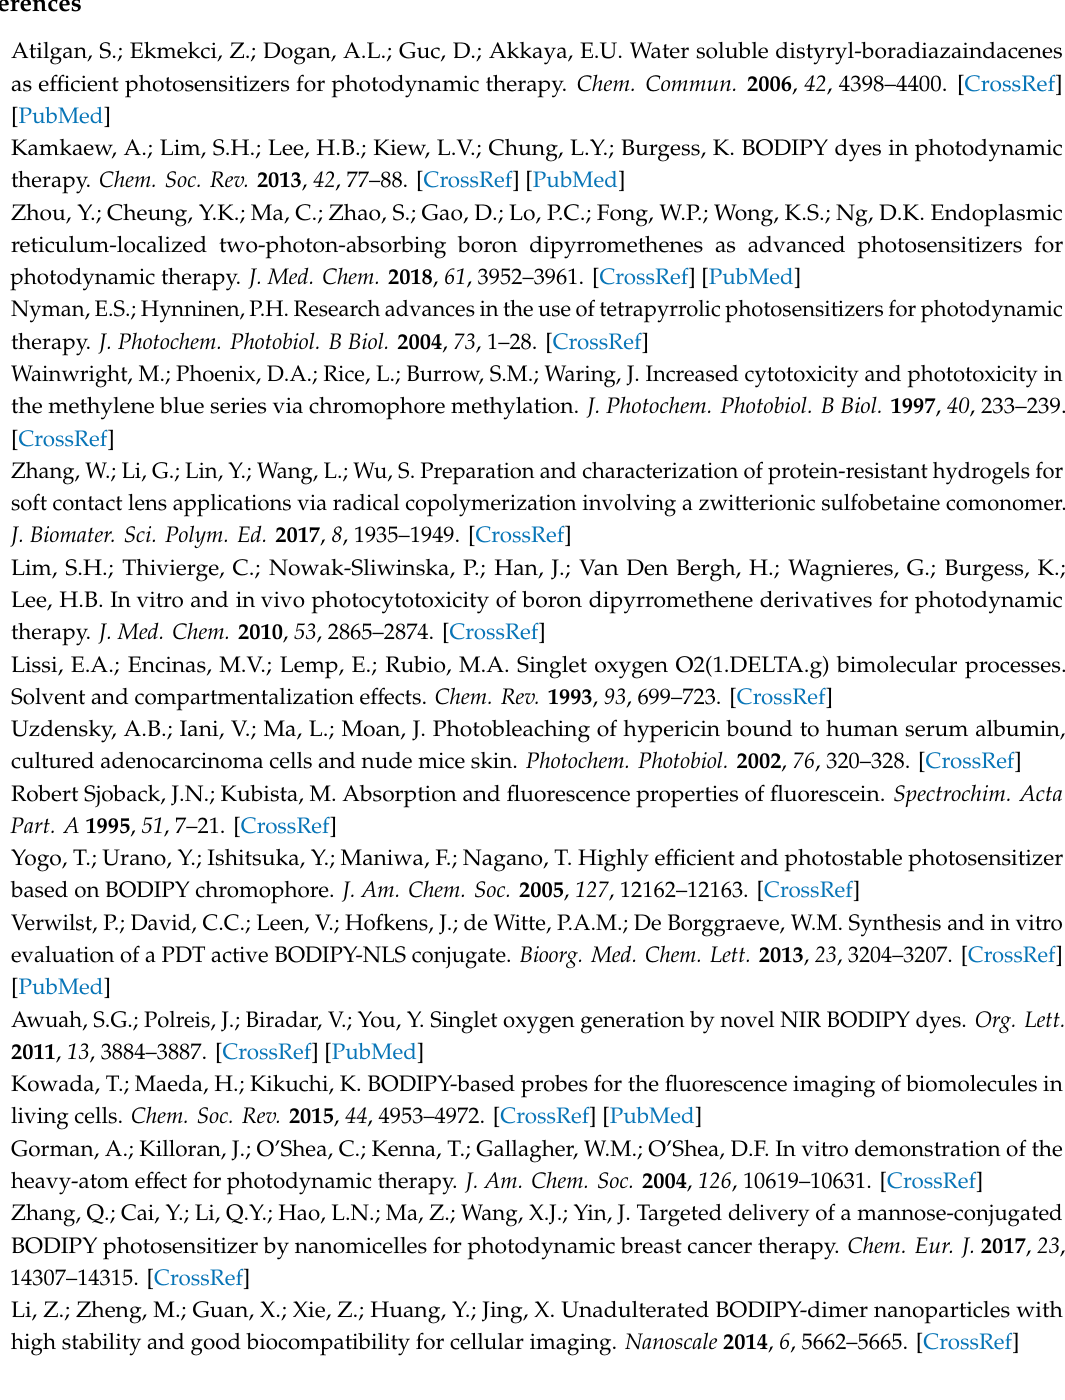
BODIPY dyes BLa, BILa, and BDILa in MCF-7 cells. Figure S8: Cell survival rates of (a) HeLa, (b) MCF-7, and (c) Huh7 cells after treatment with BLa under LED light irradiation at 530